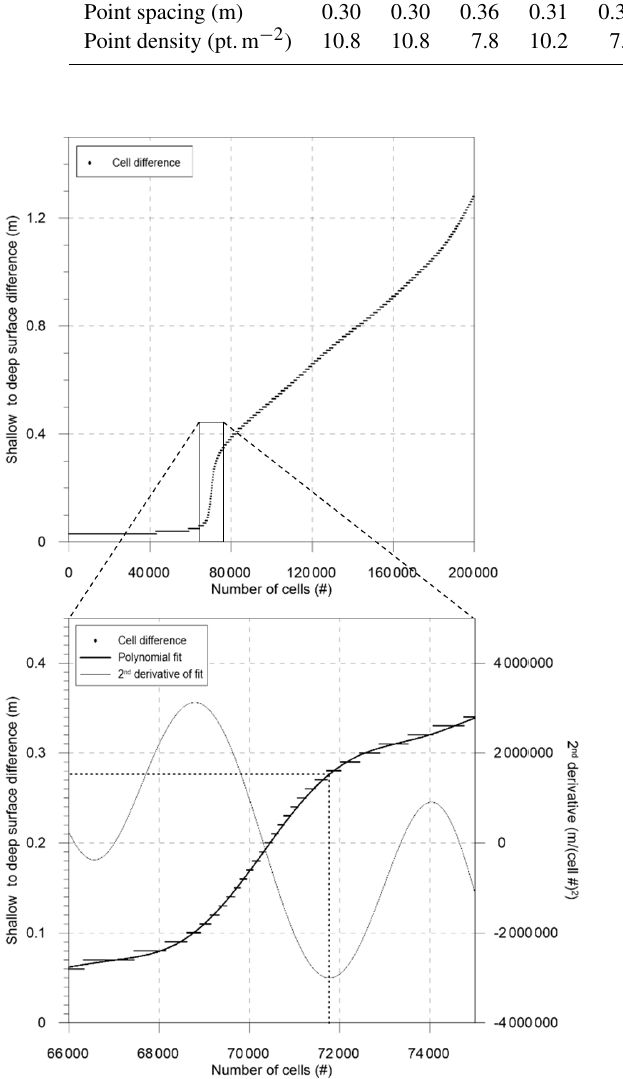
Table 2. Lidar point spacing and density for all the 11 individual swaths, which covered the study area, and for the combined swaths. Swath number